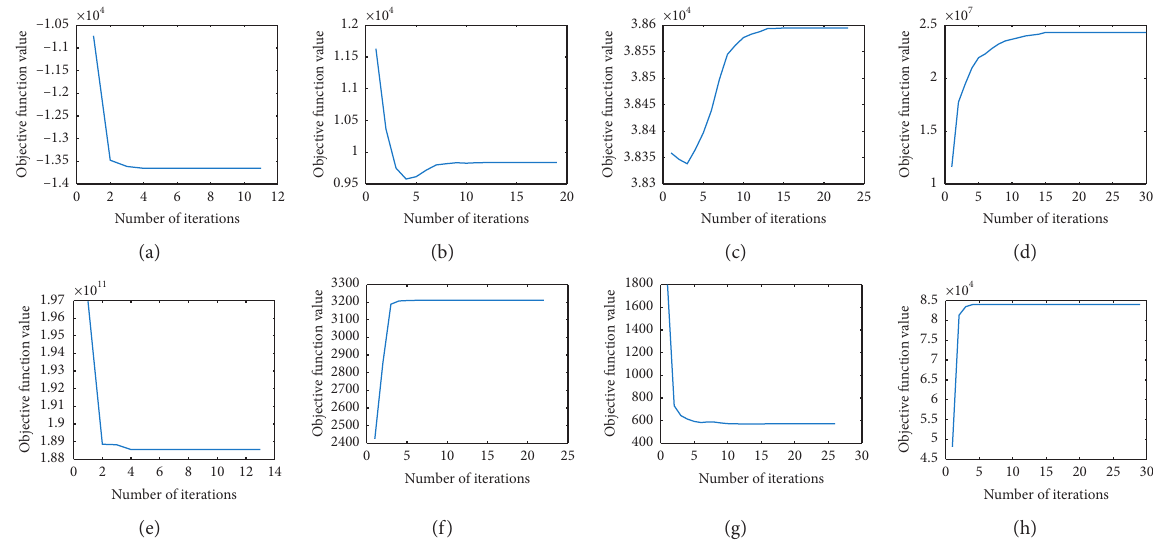
Figure 5: The convergence curves of SNCM on (a) Abalone, (b) Dermatology, (c) Dnatest, (d) Pima, (e) TOX-171, (f) Vote, (g) Vowel, and (h) WBC.